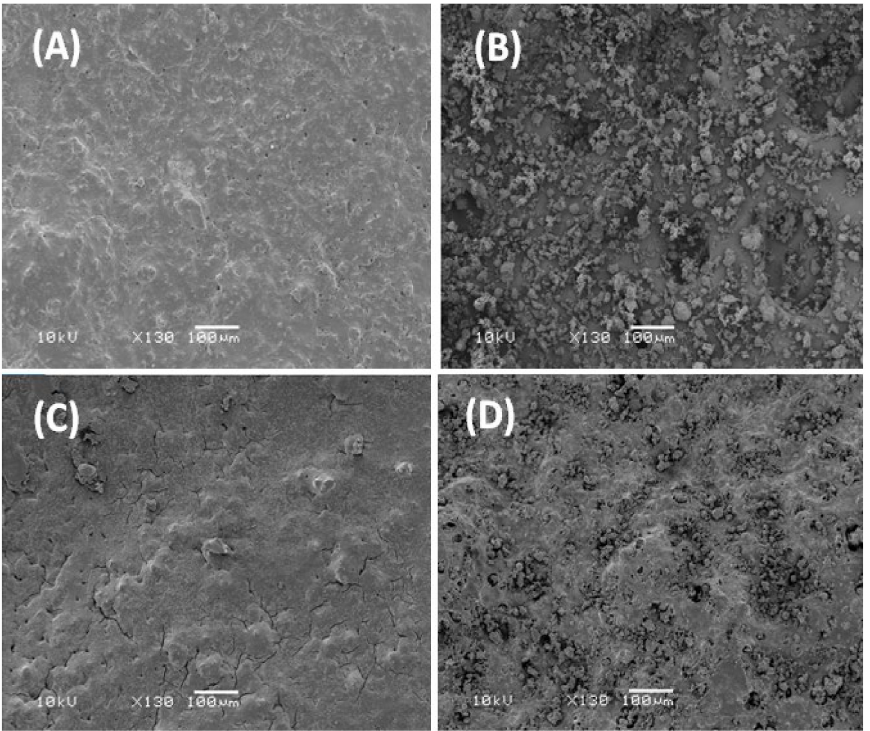
Figure 3. Scanning electron microscopy (SEM) images ( A ) PEVAL/PDVAL blend; ( B) β -TCP mi- croparticles, ( C ) PEVAL/PDVAL/ β -TCP50; ( D ) PEVAL/PDVAL/ β -TCP70 composites zoomed at 130 ×